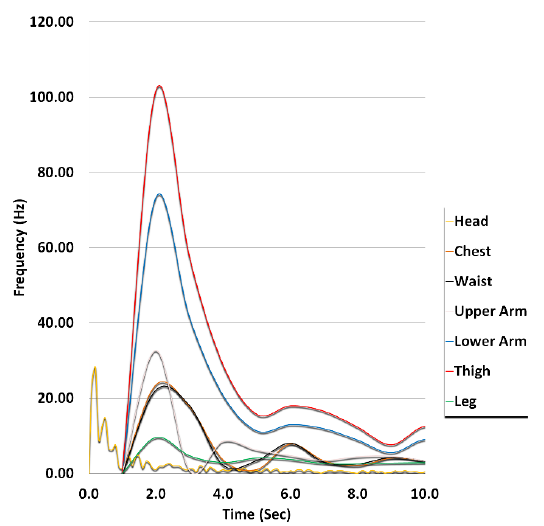
Figure 7. Frequencies at the points of interest.